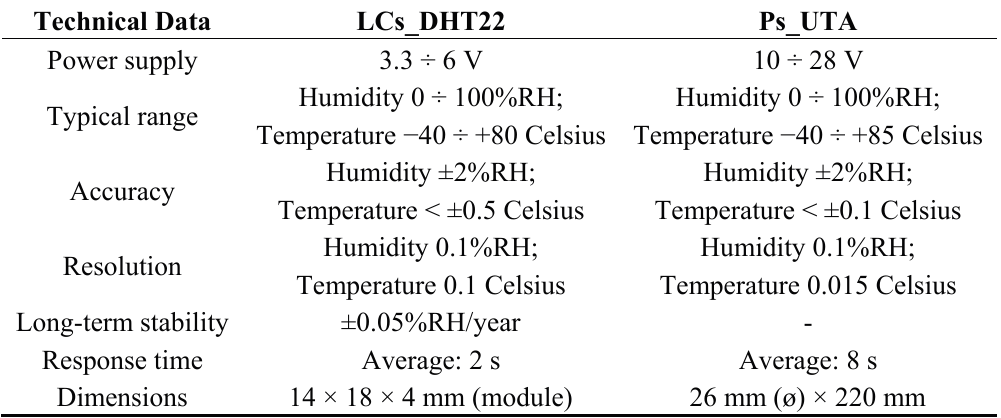
Table 2. Technical specifications sensors used to measure temperature and